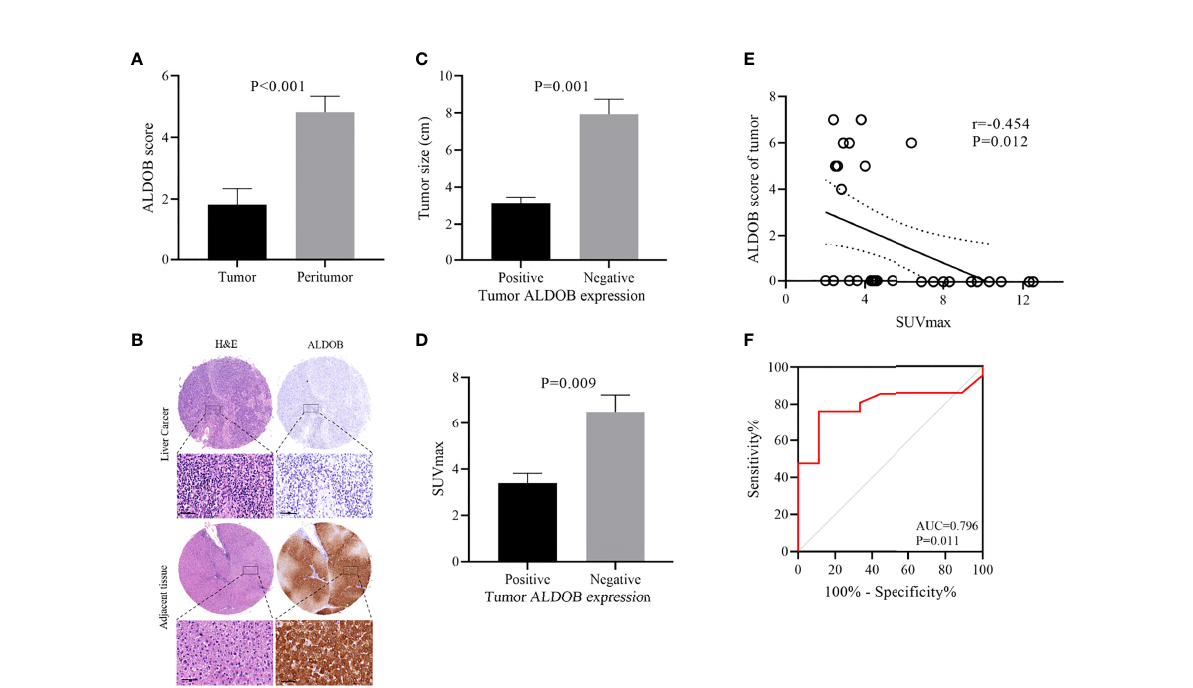
FIGURE 2 Relationship between ALDOB expression by immunohistochemistry and SUVmax in HCC patients. (A) Mean ALDOB score in HCC tissues was signi fi cantly lower than that in matched peritumor tissues (1.8 ± 0.5 versus 4.8 ± 0.5, P<0.001) (B) Histopathologic slices of peritumor and HCC tissues were stained with anti-ALDOB antibody. (C) ALDOB-negative tumors were obviously larger than ALDOB-positive ones (8 cm versus 3 cm; P=0.001). (D) SUVmax was signi fi cantly higher in ALDOB-negative tumors than in ALDOB-positive ones (6.5 ± 0.7 versus 3.4 ± 0.4; P=0.009). (E) Inverse correlation was found between SUVmax and tumor ALDOB expression score in HCC (r=-0.454; P=0.012). (F) ROC analysis of SUVmax to predict ALDOB expression. With an SUVmax of 4.15 as the threshold, sensitivity and speci fi city in the prediction of ALDOB expression were 76.2% and 88.9%. The area under the ROC was 0.796 (P=0.011; 95% CI